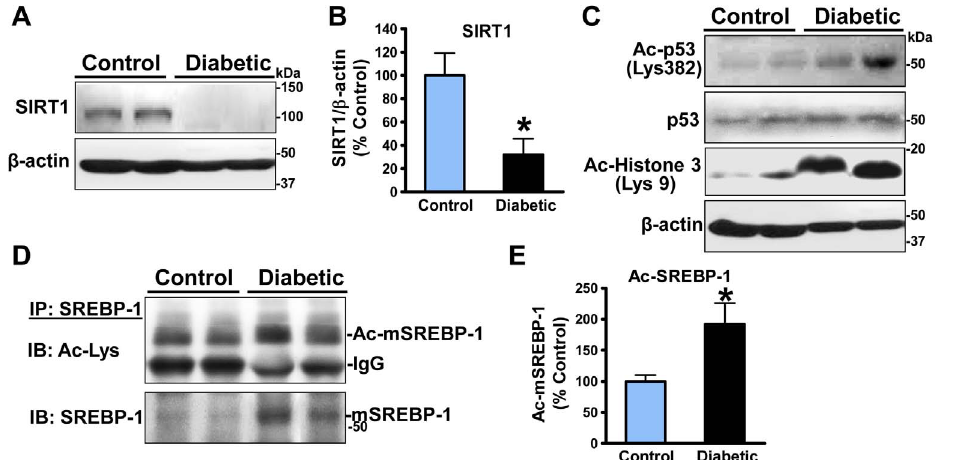
Figure 5. Downregulation of SIRT1 results in decreased deacetylation of the mature form SREBP-1 in the aorta of diabetic, atherosclerotic pigs. A and B . Expression of endogenous SIRT1 is remarkably reduced in the aorta of diabetic and atherosclerotic pigs. The protein levels of SIRT1 were normalized to those of b -actin and presented as relative levels to control pigs. C . The NAD + -dependent SIRT1 deacetylase activity, as reflected by deacetylation of p53 at Lys-382 and histone H3 at Lys-9, is diminished in the aorta of diabetic and atherosclerotic pigs. D and E . Deacetylation of mature SREBP-1 is reduced in atherosclerotic pigs. When endogenous SREBP-1 was immunoprecipitated with SREBP-1 antibody, the mature SREBP-1 in immunoprecipitates was assessed by immunoblots with an acetylated-lysine antibody and SREBP-1 antibody, respectively. Data were presented as the mean 6 S.E.M., n=3, *P , 0.05, vs control pigs.